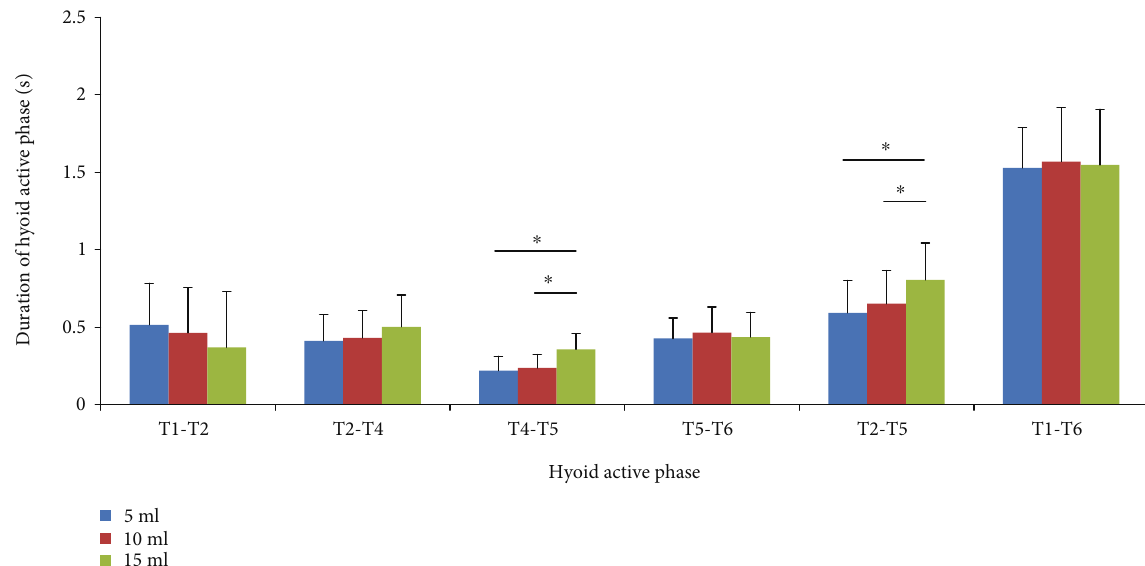
Figure 5: E ff ects of bolus volume on hyoid active phases. T1 – T2, hyoid slight motion phase; T2 – T4, hyoid elevation phase; T4 – T5, hyoid stabilization phase at the most anterior-superior position; T5 – T6, hyoid descent phase; T2 – T5, hyoid active phase; T1 – T6. hyoid total motion phase. Data were expressed as the mean ± standard deviation (SD). * P < 0 : 05 . Table 3: Correlation coe ffi cient between hyoid movement and tongue pressure among di ff erent volumes. r ( p Time points on the laryngeal waveform Event on the tongue pressure